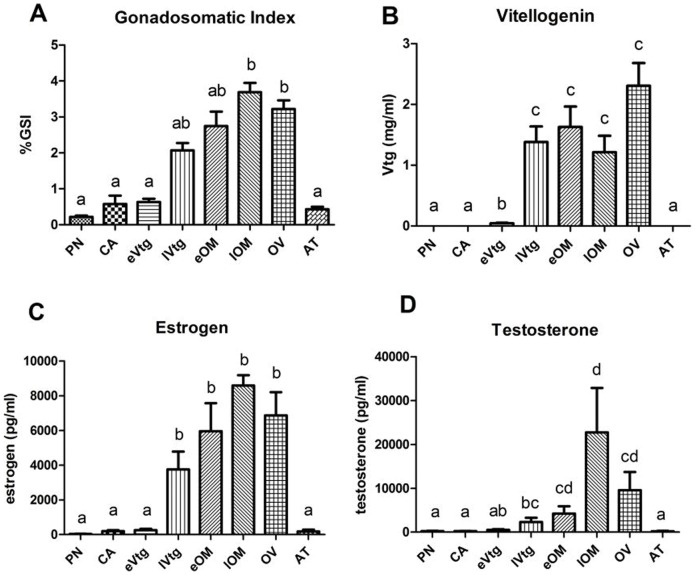
Reproductive endpoints in female largemouth bass.(A) Gonadosomatic index (GSI), (B) vitellogenin (Vtg), (C) 17β-estradiol (E2) and (D) testosterone (T) are shown at each stage for all individuals that were used in the microarray analysis (n = 4/stage). Data are presented as mean (±SEM) and were analyzed using a one-way ANOVA (log transformed data for Vtg and T) followed by a Dunnett’s T3 post-hoc test. Different letters denote significant differences among groups (p<0.05).